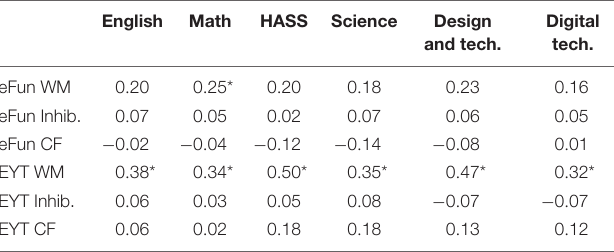
TABLE 1 | Correlations Between Grades and EF